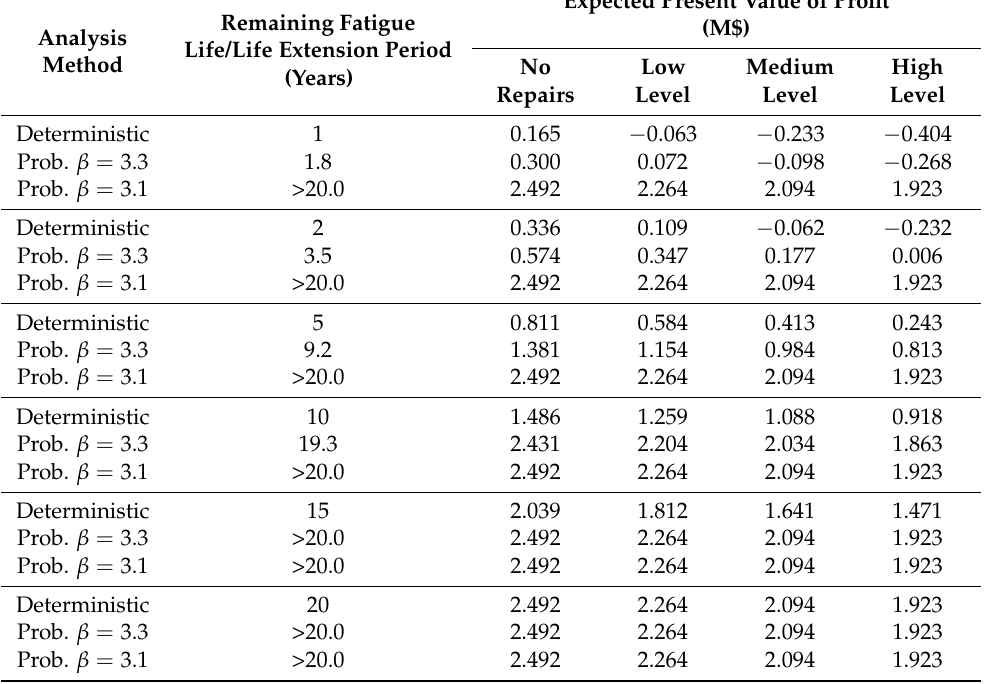
Table 1. Expected present value of the profit for four levels of retrofits: no repairs, low level, medium level, and high level for life extension periods equal to the assessed remaining fatigue life using the deterministic analysis method, and for the probabilistic analysis method for target reliability levels β = 3.3 and β =